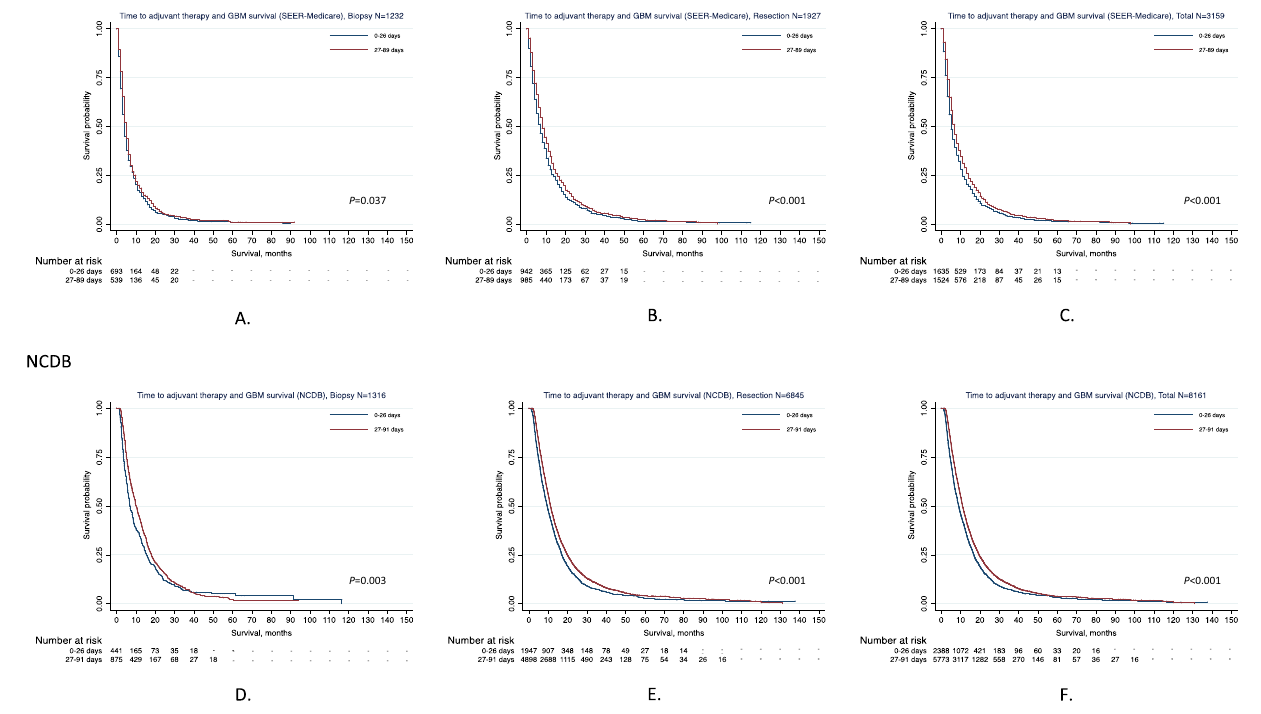
Figure 2. OS of GBM patients across time to AT (two-category) by applying the Kaplan–Meier method. *“−” was used once the number of patients was 11 or fewer based on privacy policy of both SEER-Medicare and NCDB. ( A ) OS of GBM across time to AT in patients undergoing biopsy from SEER-Medicare. ( B ) OS of GBM across time to AT in patients undergoing resection from SEER-Medicare. ( C ) OS of GBM across time to AT among total patients from SEER-Medicare. ( D ) OS of GBM across time to AT in patients undergoing biopsy from NCDB. ( E ) OS of GBM across time to AT in patients undergoing resection from NCDB. ( F ) OS of GBM across time to AT among total patients from